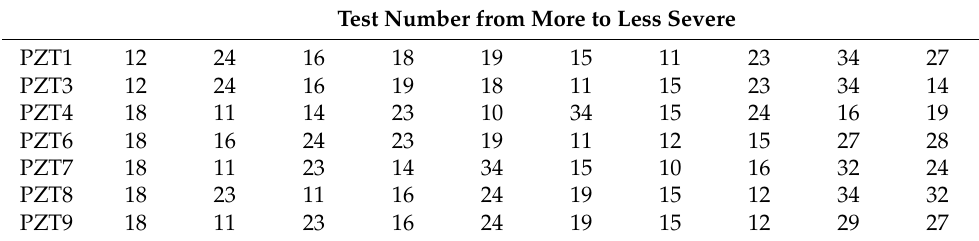
Figure 9. Damage index using the previous loading stage as the baseline. Table 3. Tests identified as having a higher damage index.